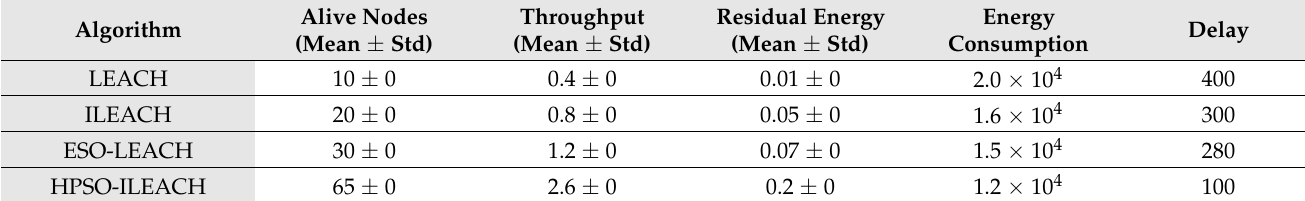
Table 5. The mean, standard deviation and range of the relevant variables.